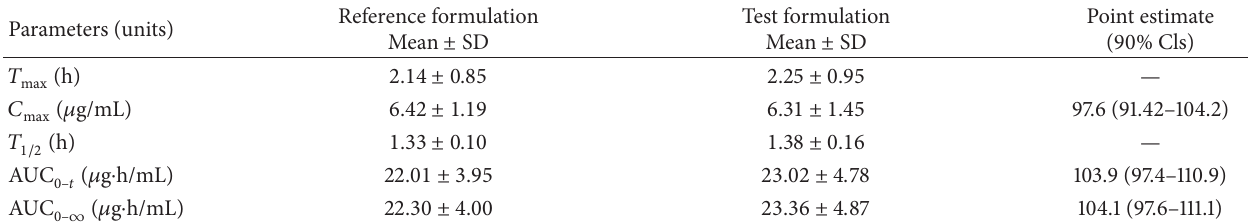
Table 3: Mean pharmacokinetic parameters for cefuroxime after oral administration of 500 mg of test and reference formulations to healthy human volunteers under fasting condition (𝑛 = 22)